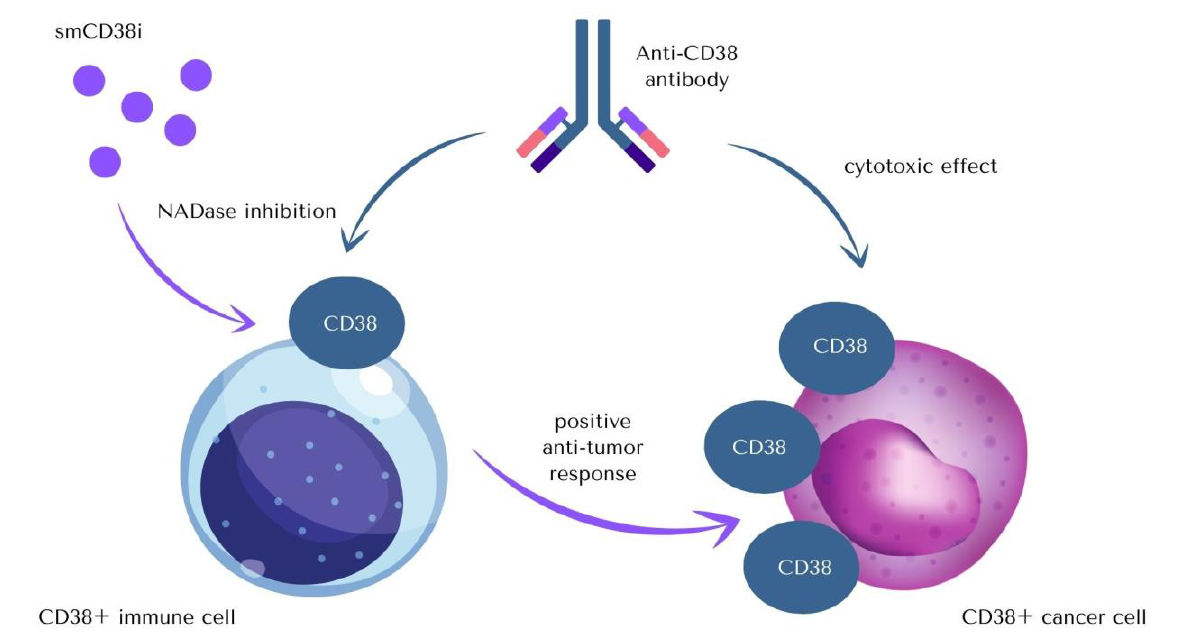
Figure 3. Cytotoxic anti-CD38 antibodies can induce apoptosis of CD38-positive cancer cells through direct or indirect effects. As the level of cellular NAD+ plays a significant role in immune system modulation, small molecule CD38 inhibitors (smCD38i) or monoclonal antibodies that inhibit CD38 activity (CD38imAB) can promote an increase in tissue NAD+ levels and induce positive anti-tumor immune response [18,70,73,74]. There are also several novel anti-CD38 targeting antibodies with the enhanced activity.